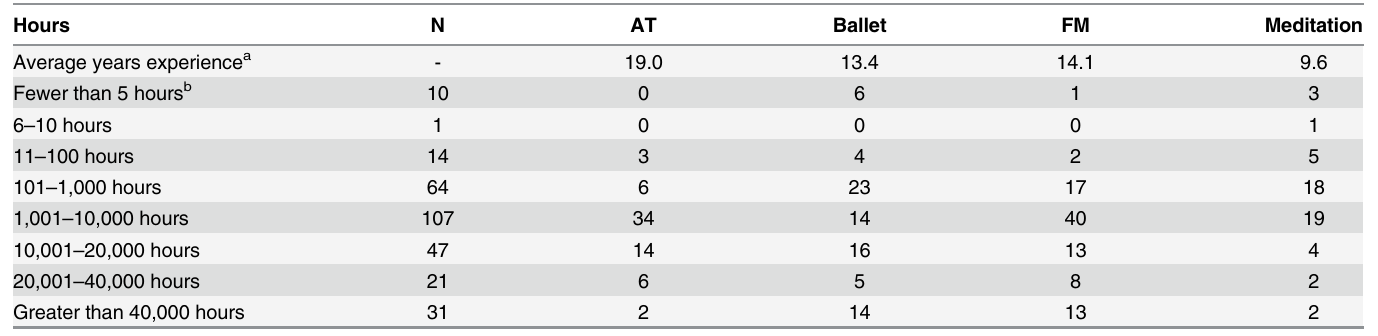
Table 2. Experience across practice